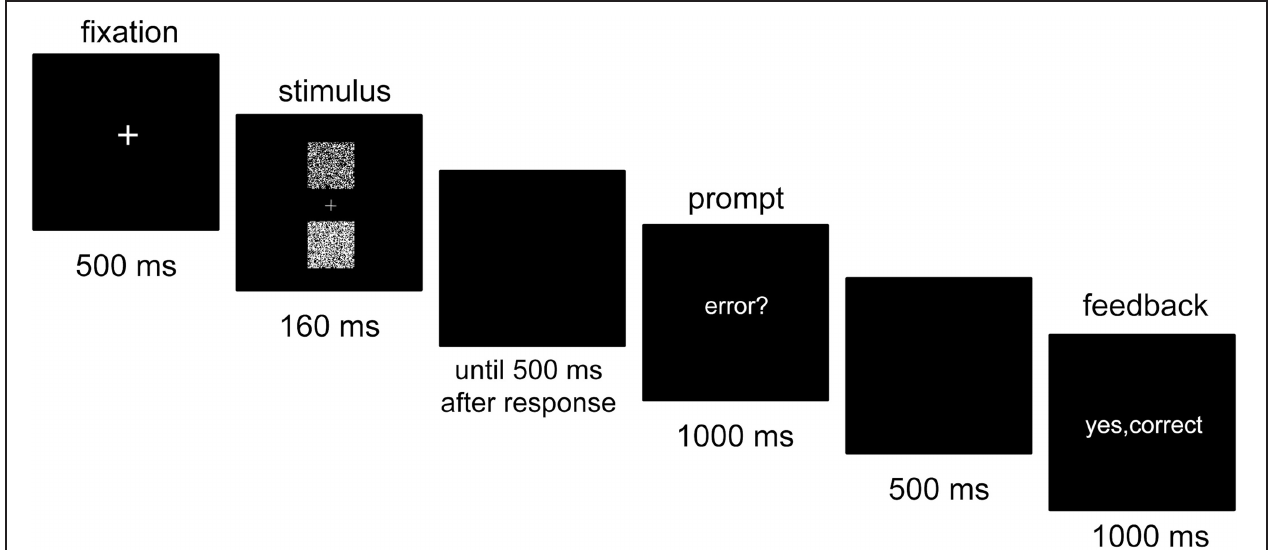
FIGURE 1 | Sequence of stimulus events in a trial. Participants were first required to indicate which of two boxes in the stimulus was brighter. Following the error prompt, they pressed a signaling key if they judged that their primary task response was an error.